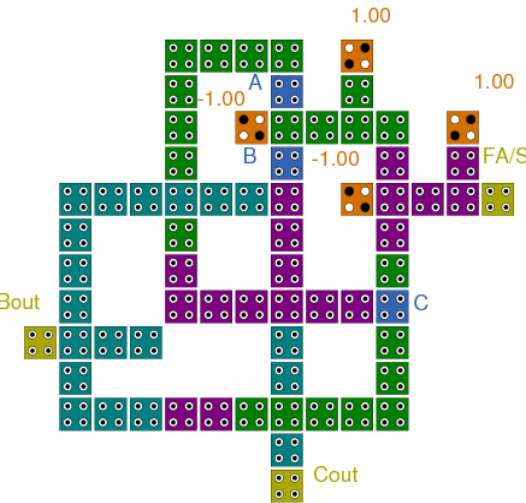
Figure 14. The proposed (A) Full Adder/Full Subtractor circuit.